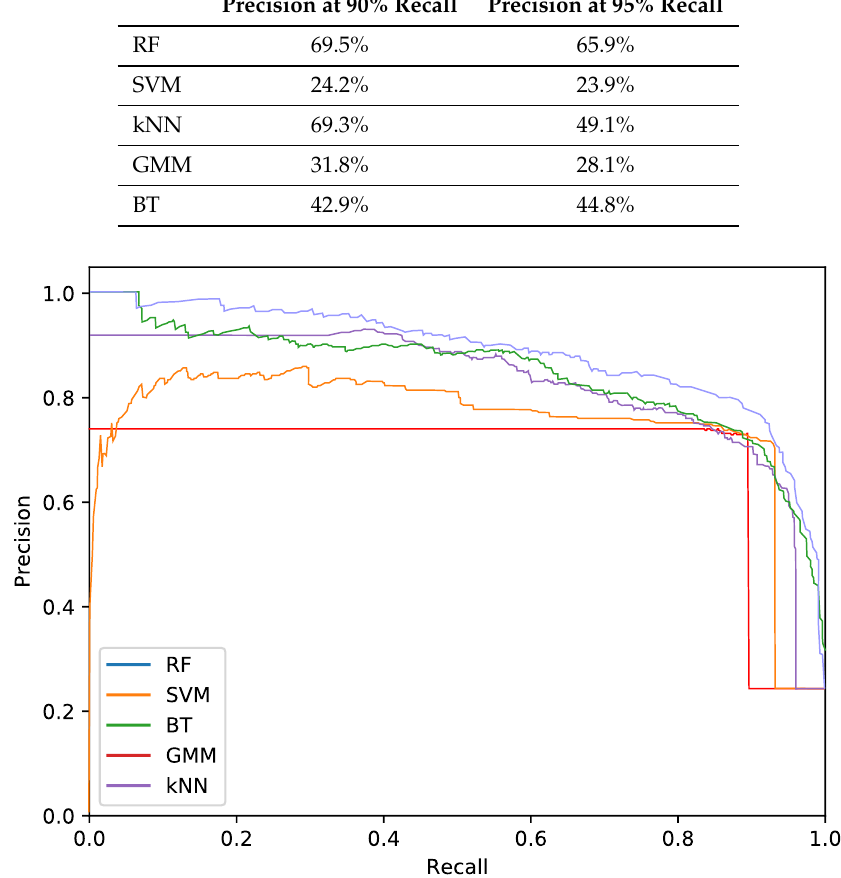
Figure 5. Precision-recall curve for the best performing classifiers using only texture